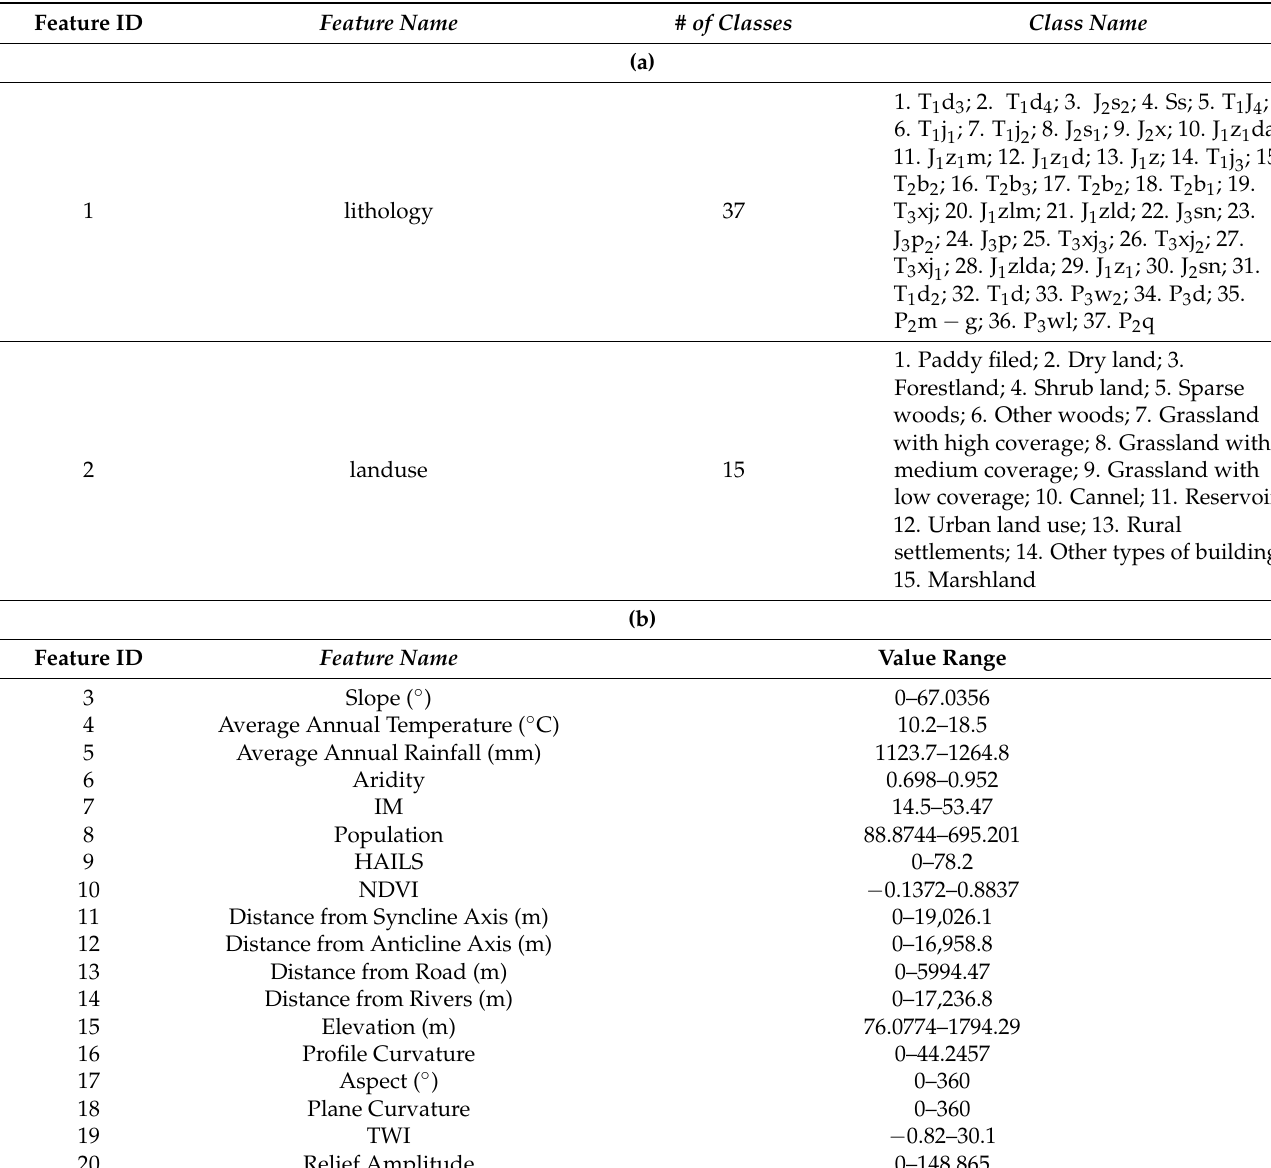
Table 2. ( a ) Categories of conditioning factors. ( b ) Ranges of conditioning